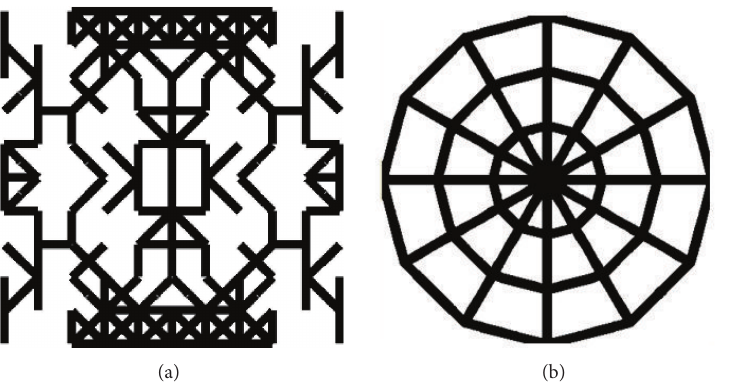
Figure 6: Examples of geometries of good performance with problem in fabrication. (a) The pattern produced by a genetic algorithm. (b) The pattern that has an output terminal in the center.